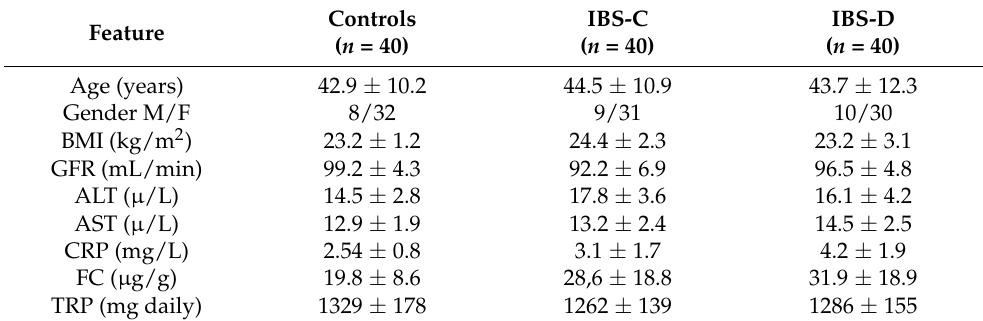
GFR—glomerular filtrating ratio, ALT—alanine aminotransferase, AST—aspartate aminotransferase, CRP—C- reactive protein, FC—faecal calprotectin, TRP—tryptophan intake; data are presented as average ± SD; differences between groups are not significant.